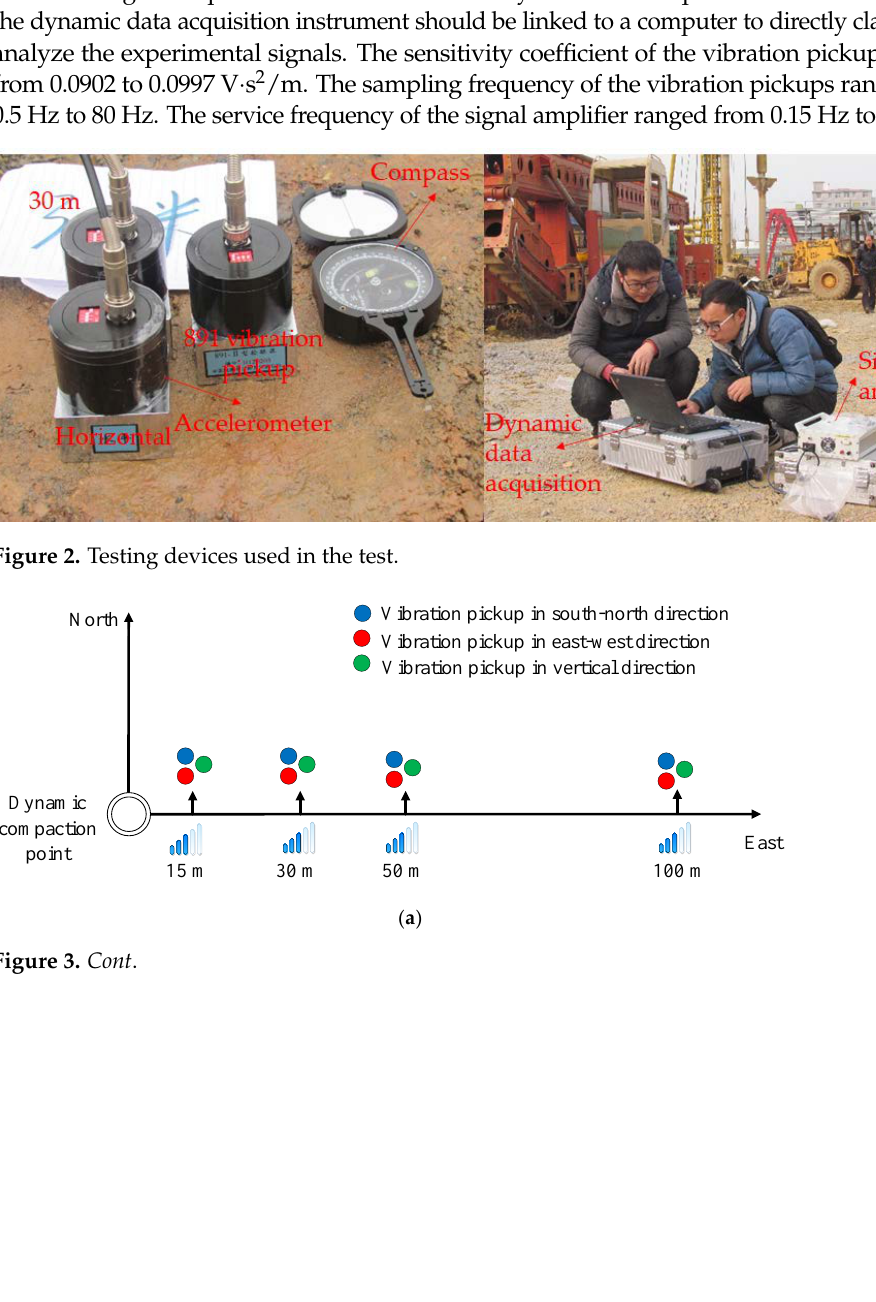
( b ) Figure 3. Sketch of monitoring points in testing site: ( a ) Sensor arrangement. ( b ) Map of testing site. 3. Results and Analysis The resonance-free vibratory hammer used here was working without counter- weight and with an eccentricity of 30 cm. In order to facilitate the analysis of the testing results, a symbolic convention rule of A–B was proposed, in which A denotes the distance between the motoring point and the vibration source (the dynamic compaction point), B denotes the vibration direction, i.e., 15-1, 15-2, and 15-3, can denote 15 m away from the vibration source in the vertical, east–west, and south–north direction, respectively. 3.1. Vibrational Signal Analysis The acceleration time history curve in each direction can be monitored by vibration pickups, and the corresponding vibration spectrum can be obtained through Fourier transform. The spectral characteristics were measured through a 3 Hz high-pass filter and a 60-Hz low-pass filter, with 3 and 60 as the lower and upper cutoff frequencies. Mean- while, peak values of velocity and acceleration of each monitoring point were obtained through acceleration signal processing. The detailed values are shown in Table 3. Table 3. Peak vibration values of monitoring points. DFTVS